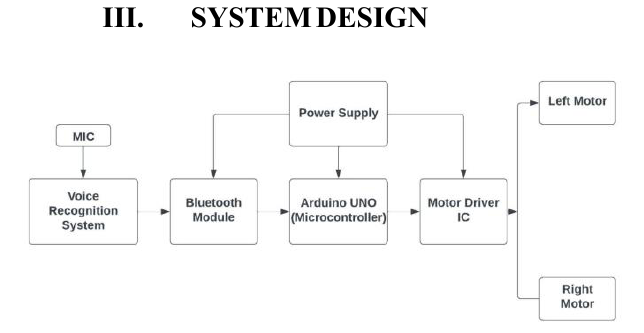
Fig 1. Block Diagram of Proposed System